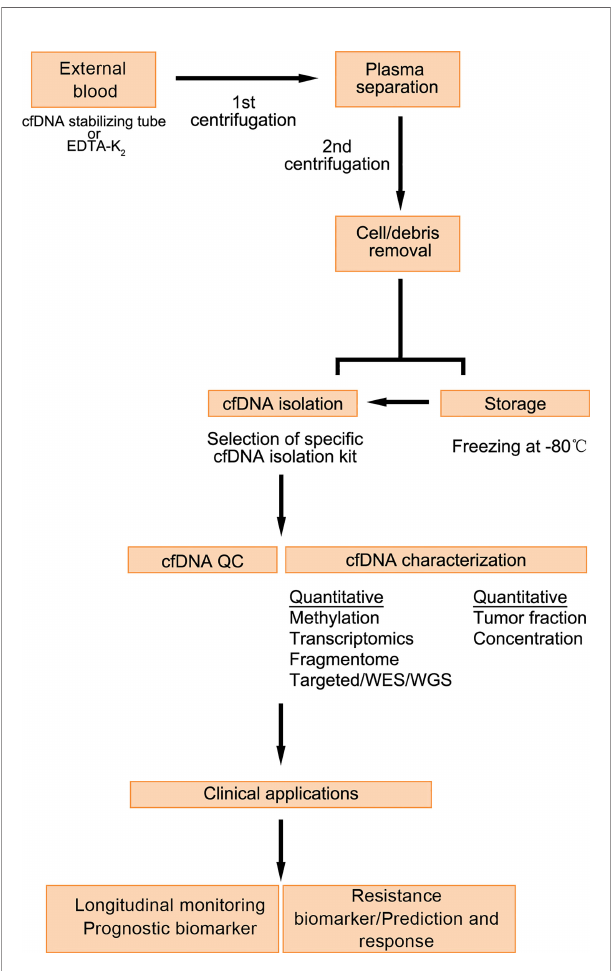
FIGURE 2 | Detection process and application of cfDNA